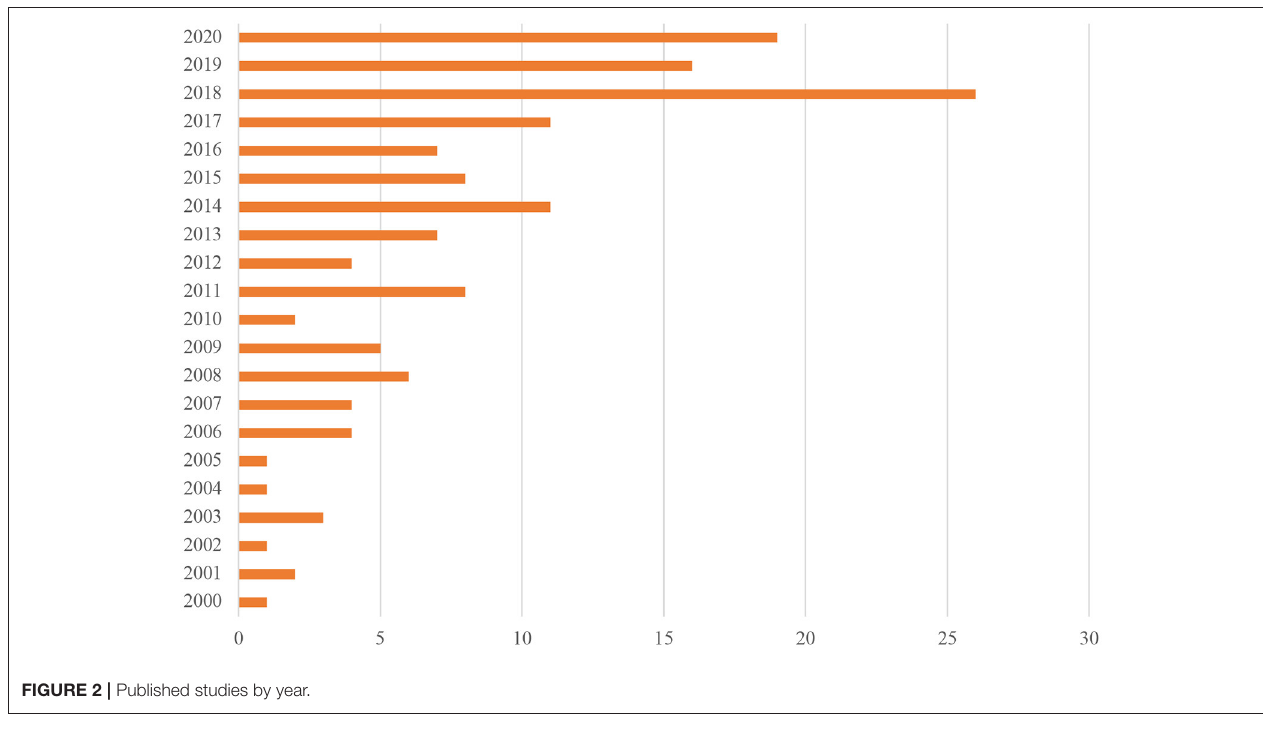
FIGURE 2 | Published studies by year.